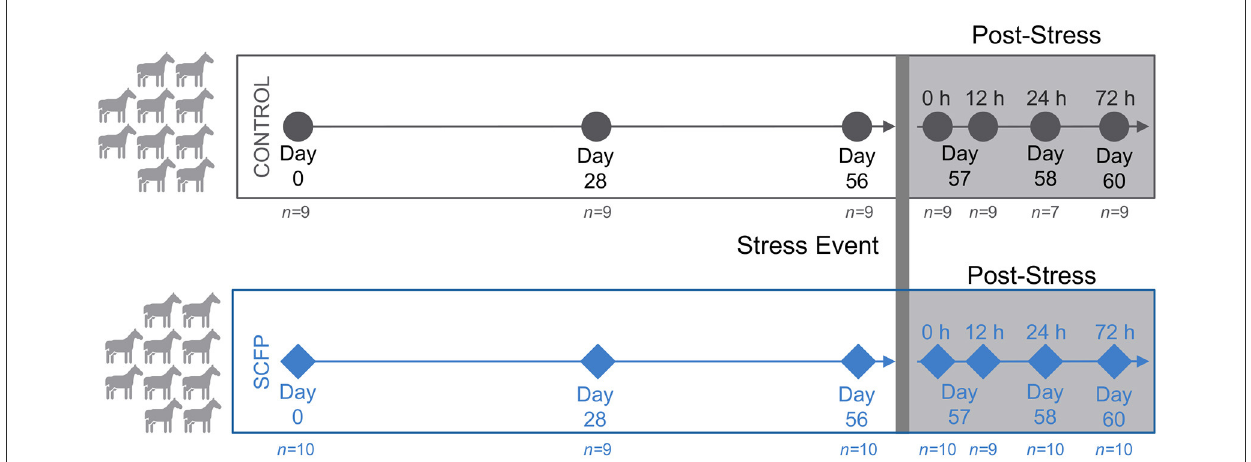
FIGURE1 Study overview. Young and clinically healthy horses were paired by age and sex and randomly assigned into Control ( n = 10) or Saccharomyces cerevisiae fermentation product (SCFP; n = 10). Horses received diets for 60 days. On day 57, horses were subjected to a previously established stress protocol to induce mild upper respiratory tract inflammation that mimicked long-distance transportation. Samples were collected on days 0, 28, and 56 before stress and at 0, 12, 24, and 72h post-stress.